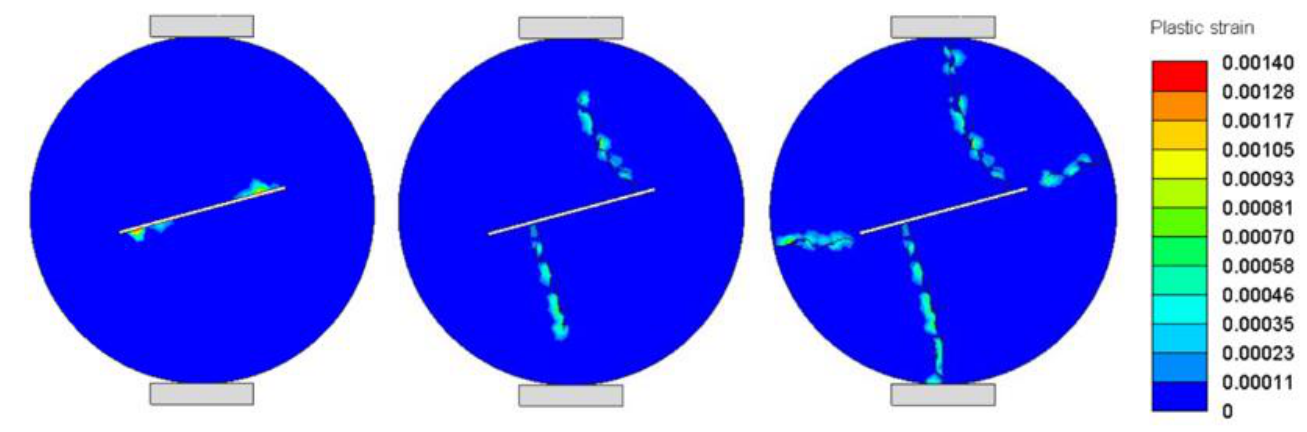
Figure 22. Plastic strain evolution for Brazilian disc with a crack of 75° angle.